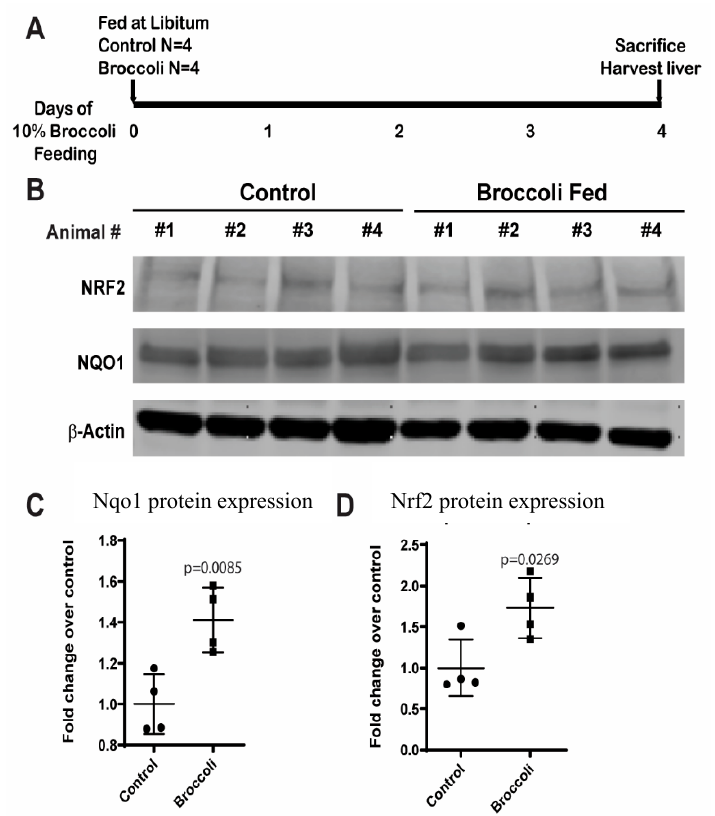
Figure 4. Broccoli feeding increases protein expression of Nqo1 and Nrf2 in rats after 14 days of broccoli feeding ( A ) Timeline of study. Rats were fed a diet with or without 10% freeze-dried broccoli ( n = 4/feeding group). ( B ) The protein expression of Nqo1 and Nrf2 in liver tissue was detected with Western blot. β -actin served as a loading control, used to normalize Nqo1 and Nrf2 protein expression and calculate data for C,D. ( C ) Quantification of Western blot results. Unpaired t -test analysis of Nqo1( C ) and Nrf2 ( D ) protein expression. p < 0.05 as compared with the control group, all data and standard deviation are plotted.